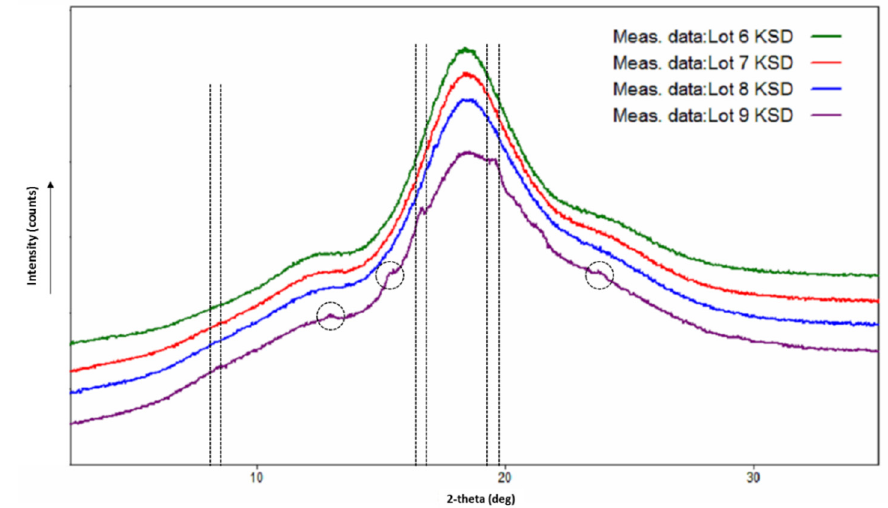
ff ractograms of abiraterone ternary Figure 7. X-ray diffractograms of abiraterone ternary KSDs. Figure 7. X-ray di